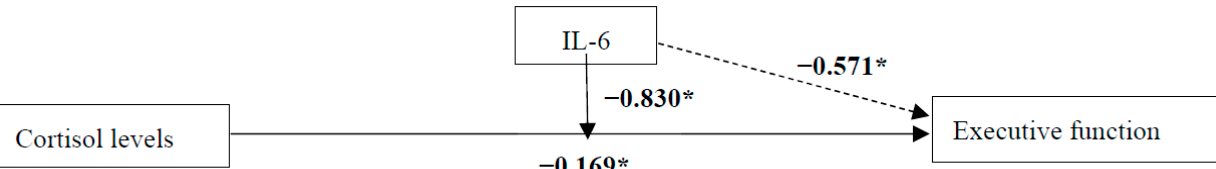
Figure 2. Unstandardized regression coefficients for the relationship between cortisol levels and executive function with moderator IL-6 in the total sample. Sex, waist circumference, depression diagnosis, and performance in a receptive vocabulary task, as a measure of educational level, were included as confounders in all models. * p ≤ 0.05.